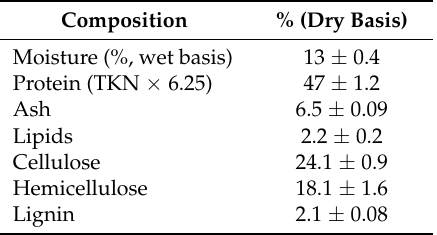
Table 2. Composition of soybean cake.